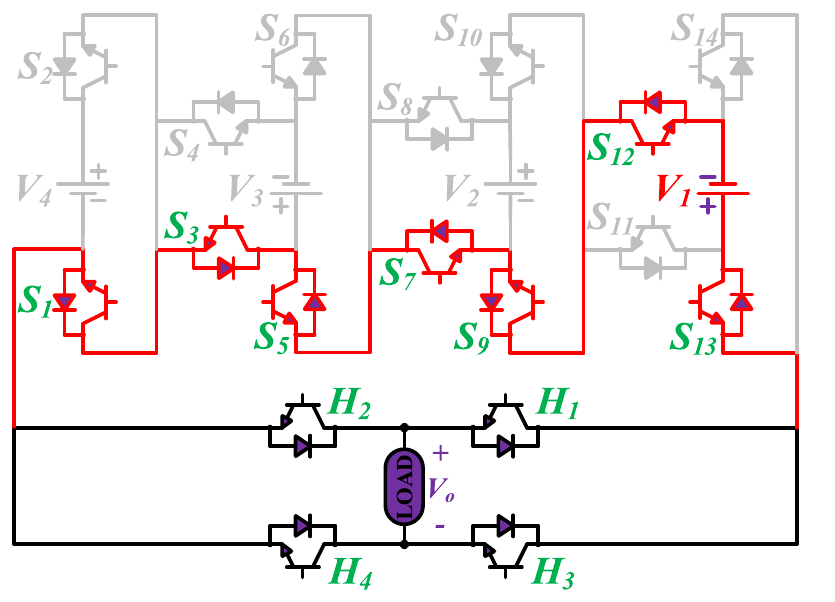
The initial zero level is generated by turning ON the switches S zero voltage level can also be obtained by turning ON either H switching states for various selected output voltage levels are shown in Figs 2–13. The switch- ing states only show the addition or subtraction of DC power sources. The corresponding posi- tive or negative levels can be obtained by configuring the respective H-bridge switches. The